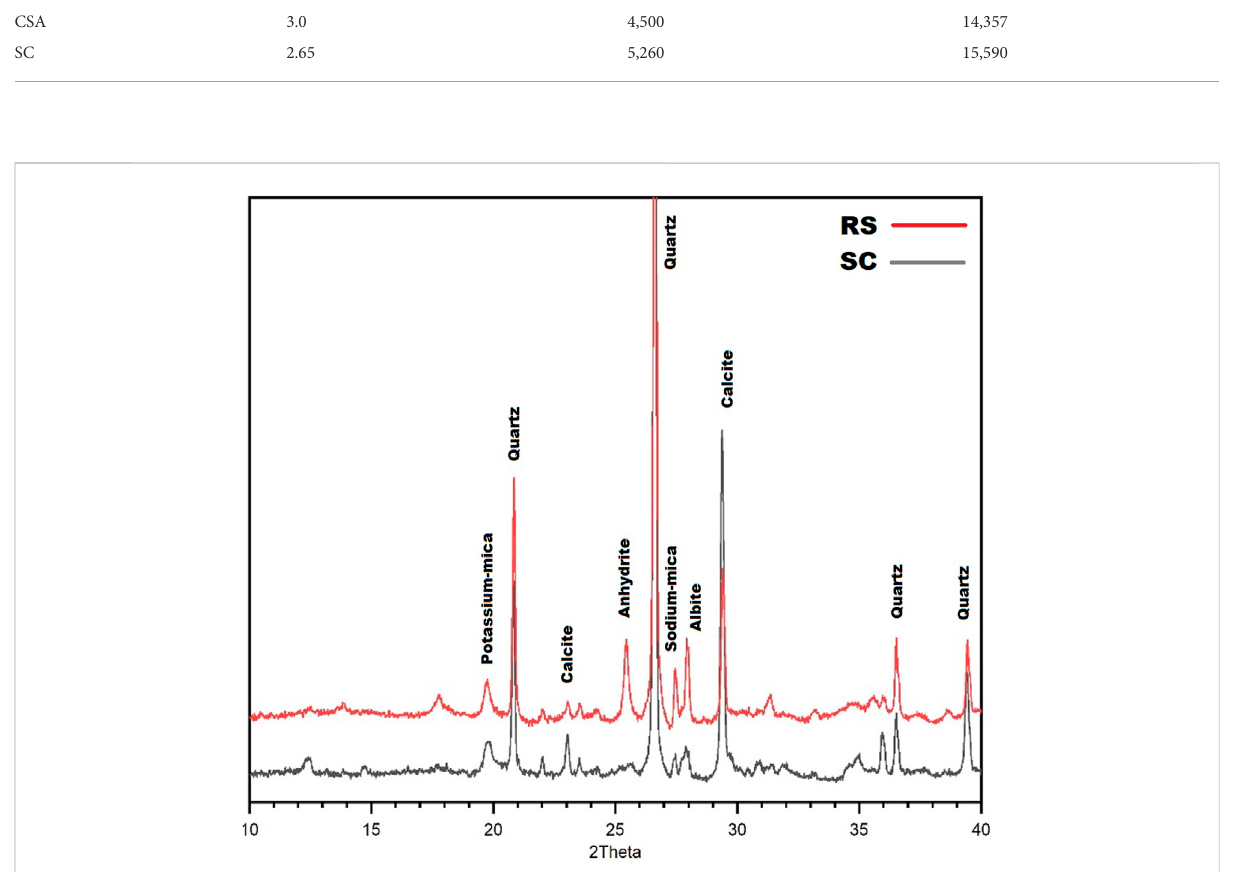
FIGURE 4 Particle size distribution for the CSA cement, SC, and normalized sand